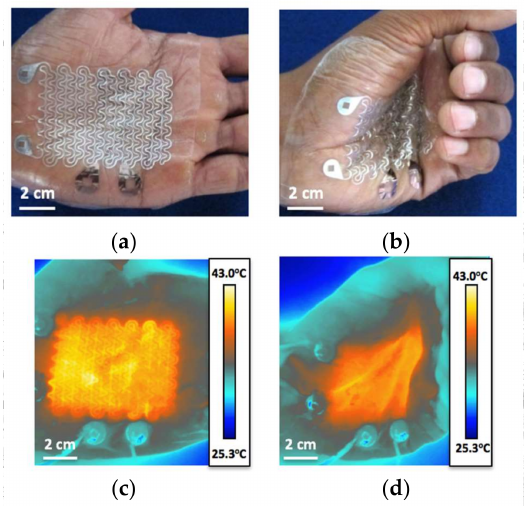
Figure 2. ( a , b ) Device conforms to hand and maintains its conformability during opening and closing; ( c , d ) Infrared (IR) images of the device powered with proportional-integral-derivative (PID) control as the hand is opened and closed. The PID controller automatically adjusts power output so the hand does not overheat when it closes.